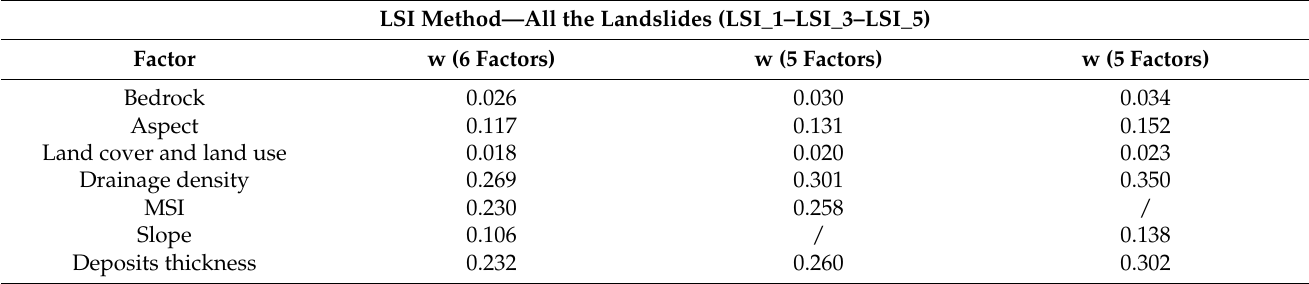
Table A2. Factors’ weights for the models LSI_1–LSI_3–LSI_5.